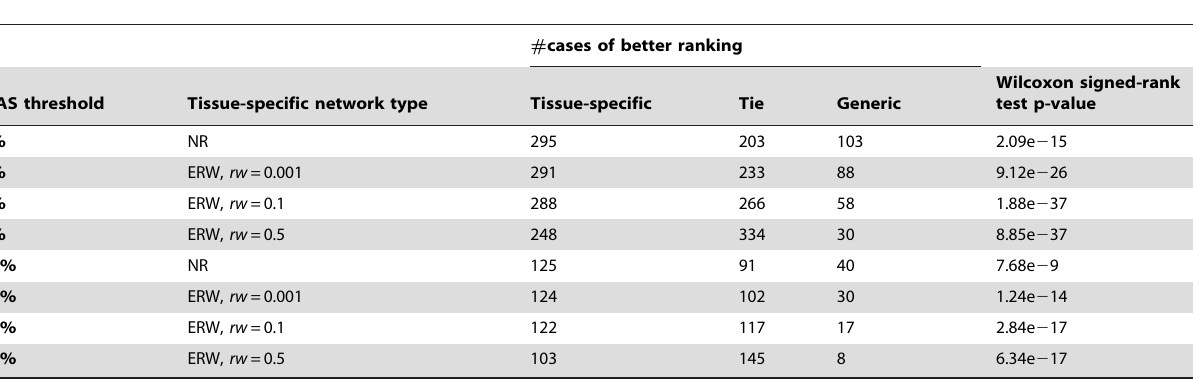
Table 1. Evaluation of generic and tissue-specific gene prioritization methods according to their ranking of the true causal genes.